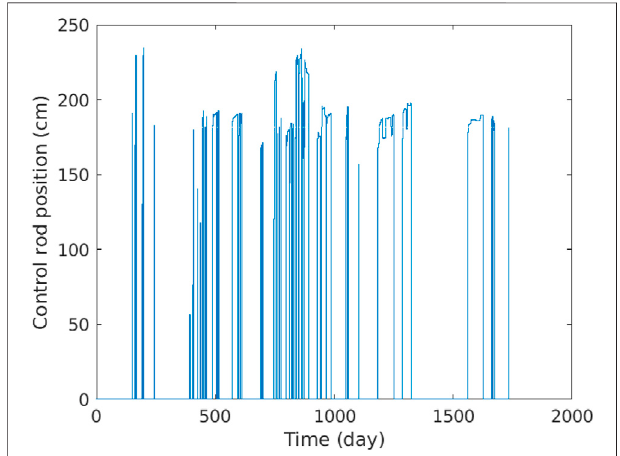
FIGURE3 | Control rod position (averaged) during the operation